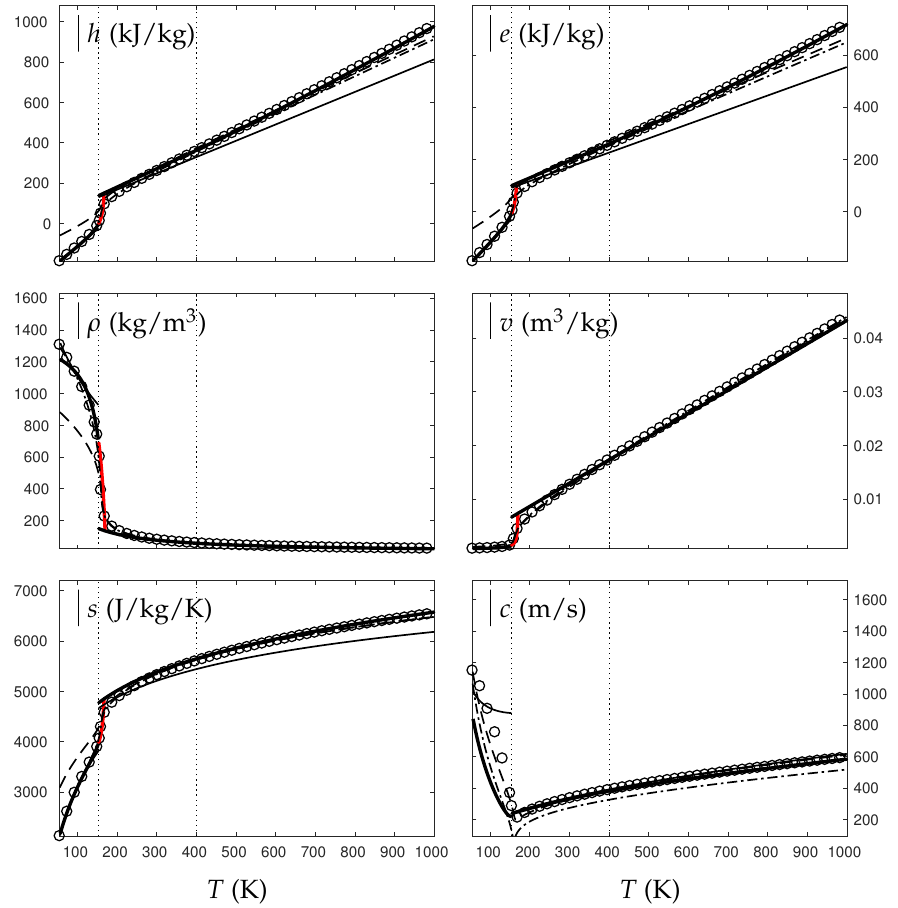
Figure 6. Comparison between experimental and theoretical isobar for oxygen. The symbols represent the experimental isobar p = 60 bars. Beyond the critical temperature T c = 154 K, the liquid transforms to supercritical state. The thick solid lines represent the Extended NASG (ENASG) EOS, reducing to the ideal gas description for the supercritical phase, Equations (56), (57) and (60). The thin solid lines represent the original NASG EOS also reducing to the ideal gas formulation for the supercritical phase. The dashed lines represent the van der Waals (VdW) theoretical predictions and the dashed-dotted lines represent the Soave–Redlich–Kwong (SRK) ones. The critical temperature is indicated with the dotted lines. From this temperature, the liquid ENASG EOS is extended and joins the ideal gas EOS (except for the sound speed). The temperature T 0 = 400 K at which variable heat capacities are considered is indicated in dotted lines as well.